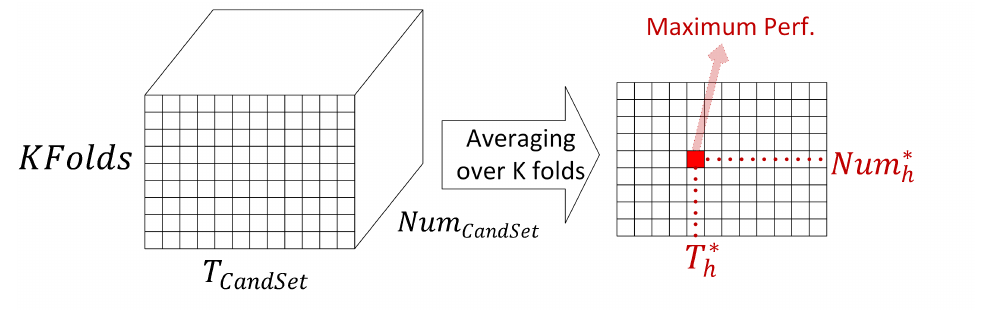
Figure 8. Illustration of the 3D array of validation accuracy for the horizontal stripe parameters and the 2D array of average validation performance obtained by averaging over K-folds of the 3D tensor for selection of T ∗ and Num ∗ parameters. h h